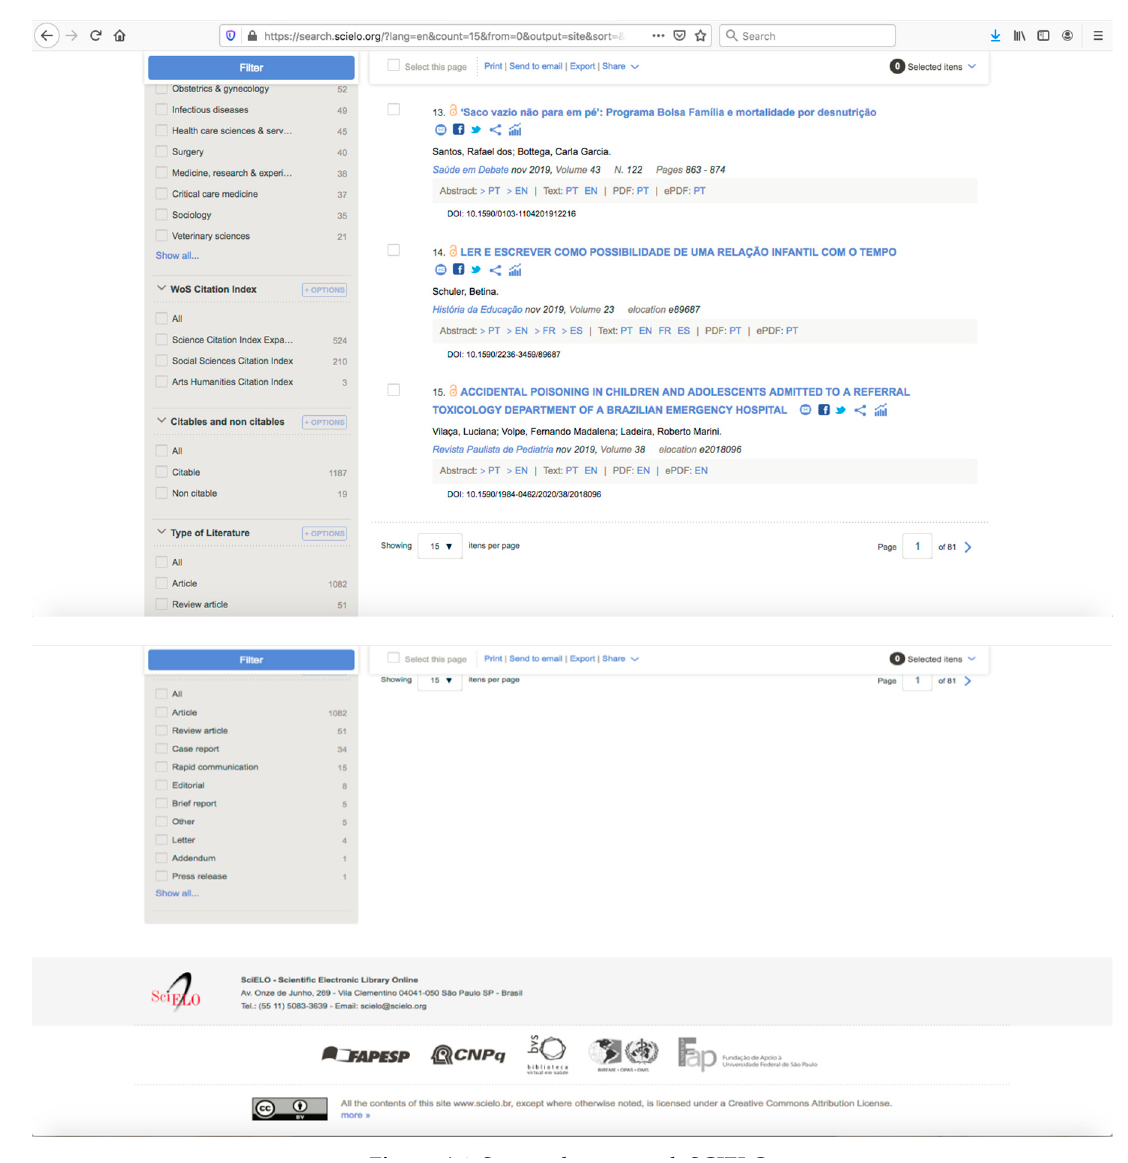
Figure A4. Screen shot research SCIELO.